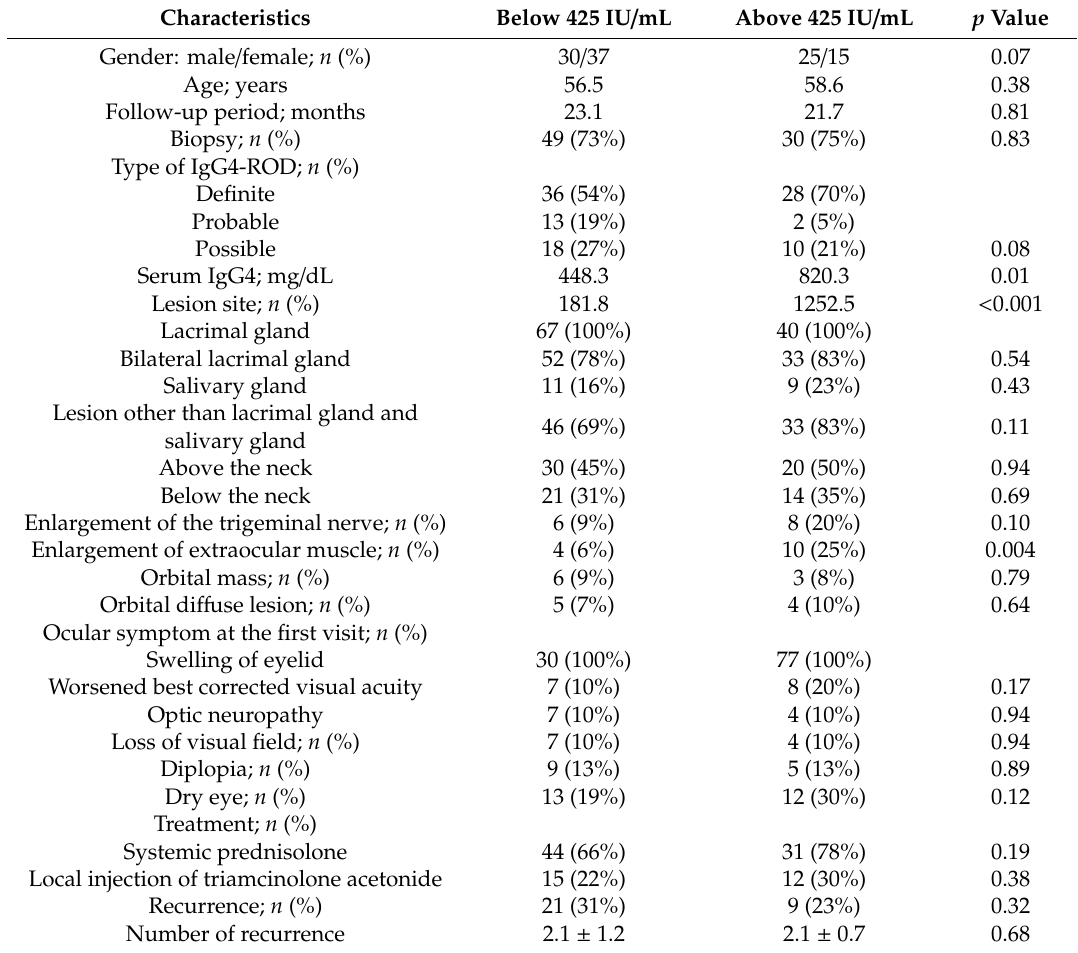
Table 8. Clinical findings in patients stratified by serum IgE concentration of 425 IU /